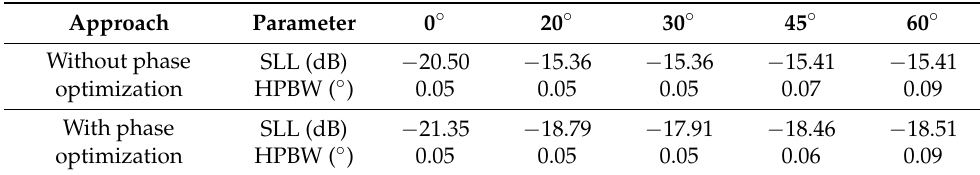
Table 1. Far field radiation characteristics of nonuniform array. Approach Parameter 0 ◦ 20 ◦ Without phase SLL optimization